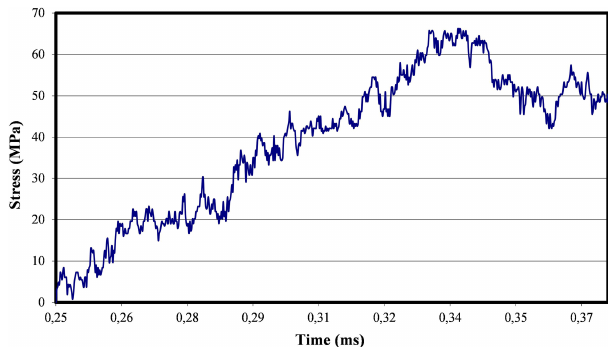
Figure 28. Stress-time curve pertinent to the actual experiment when using 1mm thick damping rings (transmission